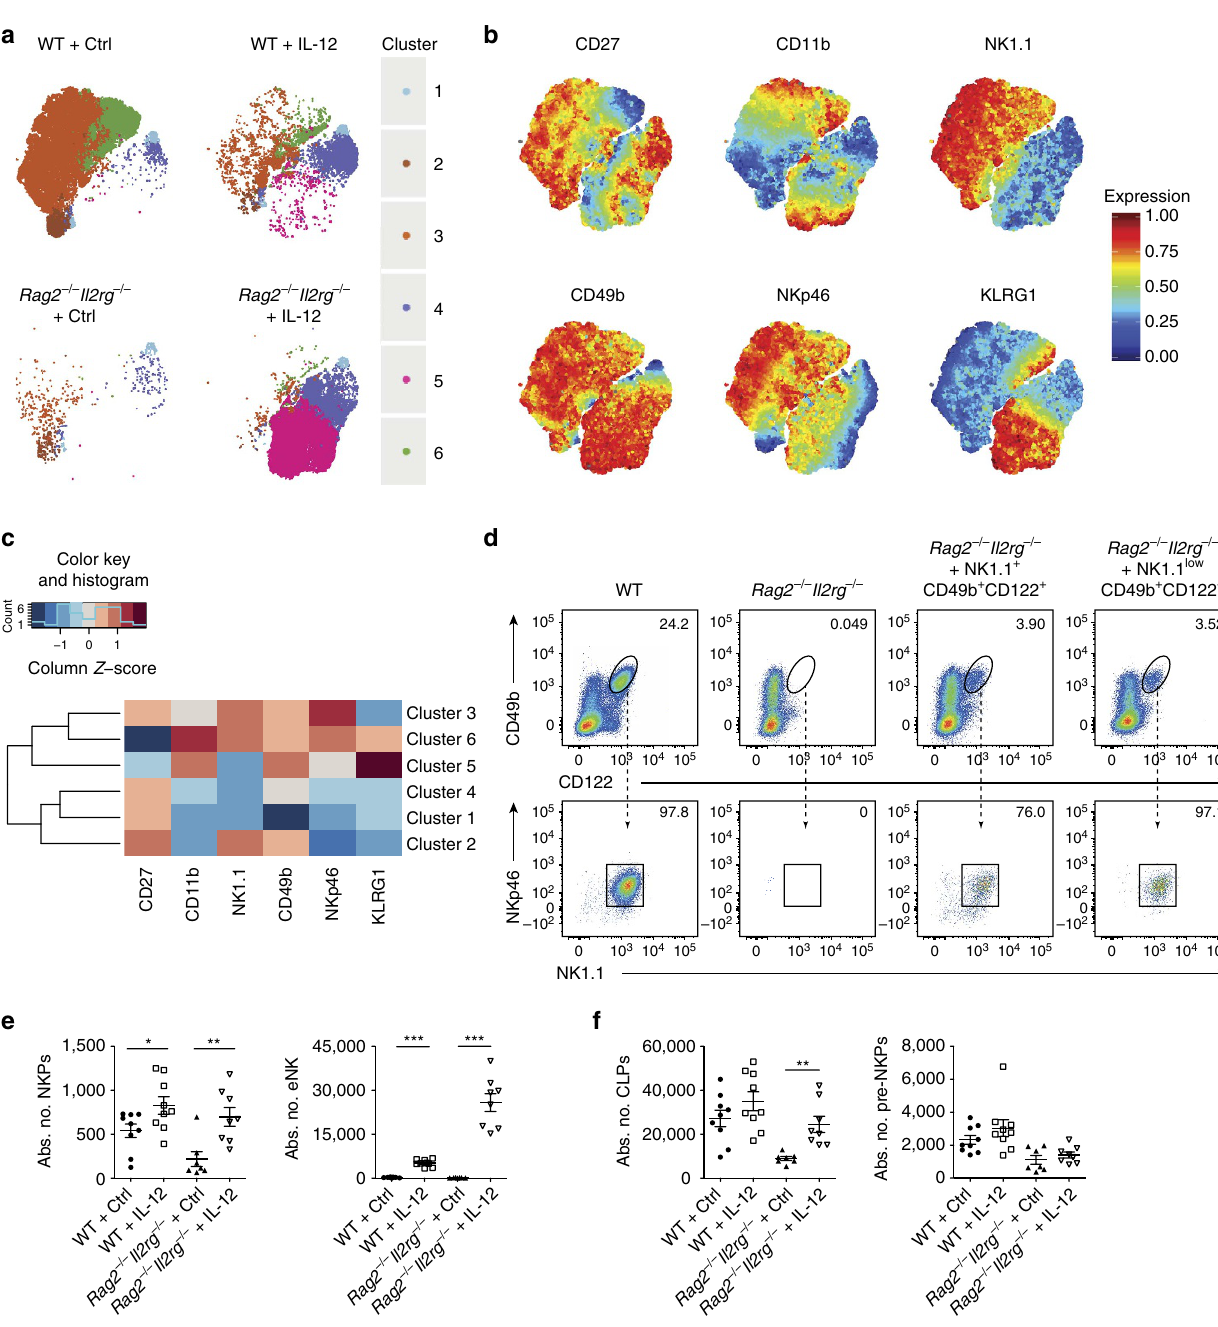
NK cells have been classically identified based on their expression of NK1.1 and NKp46 (ref. 22). Thus, the finding that eNK cells only express low levels of both lineage markers initially raised doubts whether eNK cells are actually NK cells. Further- more, the similarities between NK cells and the group 1 innate